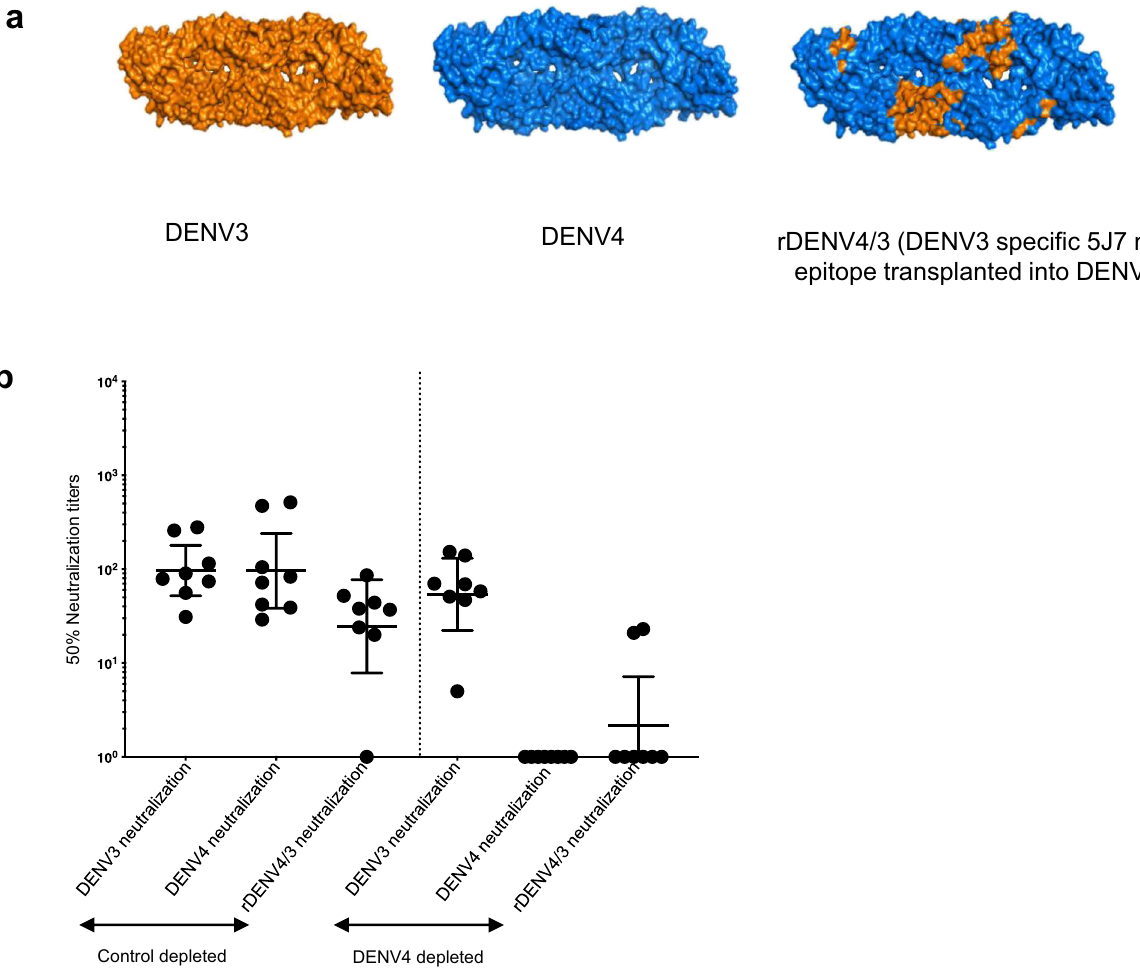
Fig. 6 TV003 induce varying levels of DENV3 serotype-speci fi c responses that do not track with known DENV3-neutralizing epitope. a DENV3 wt (orange), DENV4 wt (blue), rDENV4/3 with DENV3-speci fi c 5J7 mAb epitope transplanted into DENV4 (shown in orange) are depicted. b Panel of 8 TV003 sera ( n = 8) with evidence of DENV3 TS responses were subjected to depletions against DENV4 to map the DENV3 TS nAb epitopes using the rDENV4/3 virus. Figure shows the Neut 50 titers for the BSA depleted and the DENV4 depleted serum samples against DENV3 wt, DENV4 wt and the rDENV4/3 viruses. Data were analyzed from a total number of eight subjects indicated as dots from a single independent experiment and expressed as geometric mean titers ± 95% con fi dence intervals of the grouped samples ( b